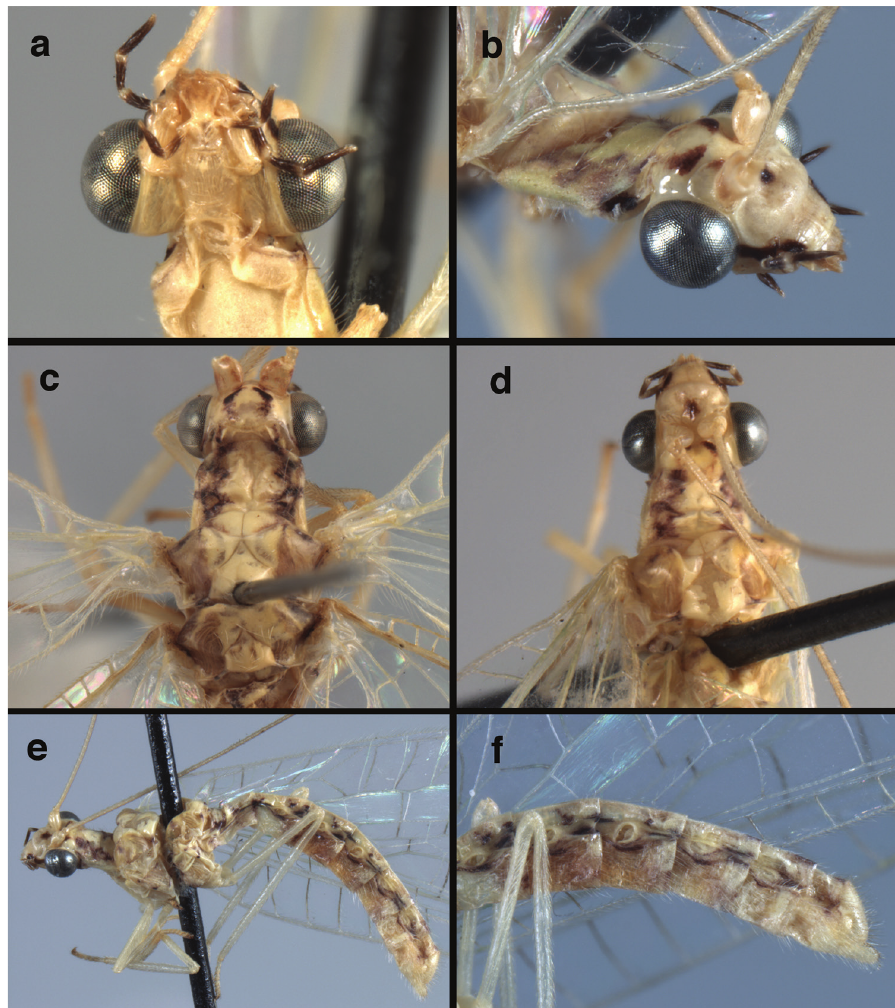
Figure 5. Ungla adamsi Tauber , sp. n. External features, ( a ) head, ventral ( b ) head, dorsolateral ( c, d ) head, thorax, dorsal ( e ) body, lateral ( f ) abdomen, lateral (all: Peru, Machu Picchu; a, b paratype, male, FSCA; c paratype, female, BMNH; d, e, f holotype, male, FSCA). Ungla adamsi resembles three other Ungla species that have frontal spots and cream-colored flagella – U. stangei sp. n., U. favrei , and U. nigromaculifrons . However, none of these species express sexual dimorphism in the frons. Ungla adamsi also differs in that it lacks the features that distinguish the other three species. That is, it has diffuse reddish marks on the scape, not a distinct stripe like the one that typifies U. favrei . It has moderately sized forewings (< 15 mm), with 7-8 gradate veins per series, not the very large wings that distinguish U. stangei ; and the veins on its hindwings are green, unlike the very dark transverse veins on the fore and hindwings of U. nigromaculifrons